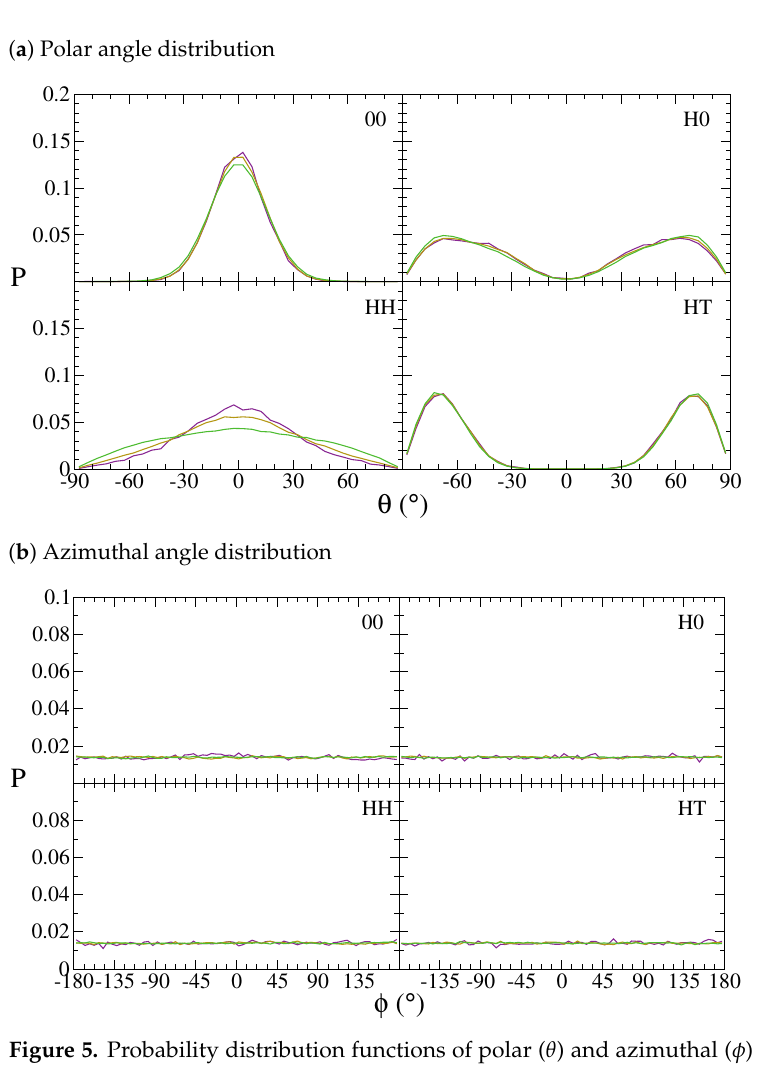
Figure 5. Probability distribution functions of polar ( θ ) and azimuthal ( φ ) angles at particle mass fractions 1wt% (purple lines), 5wt% (yellow lines) and 10wt% (green lines).